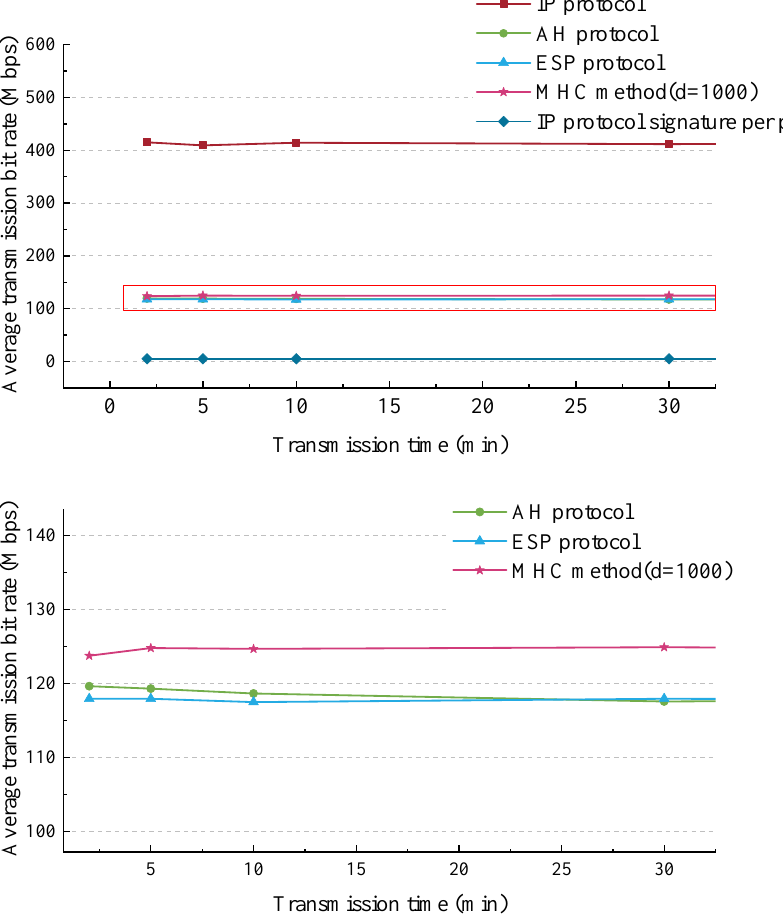
Figure 4. Comparison of average transmission efficiency of five communication